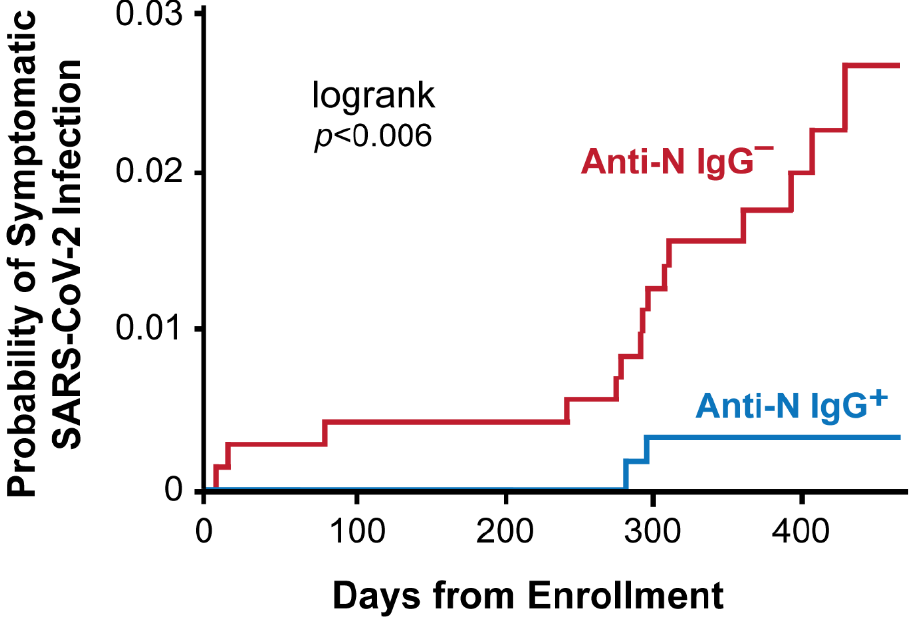
Figure 1. Cumulative probability of symptomatic SARS-CoV-2 infection by anti-SARS-CoV-2. nu- cleocapsid IgG serostatus at enrollment. Anti-N IgG + = anti-SARS-CoV-2 nucleocapsid IgG positive, indicates a prior SARS-CoV-2 infection detected through antibody testing at enrollment ( n = 616). Anti-N IgG − = anti-SARS-CoV-2 nucleocapsid IgG negative, no evidence of a prior SARS-CoV-2 infection at enrollment ( n = 718).